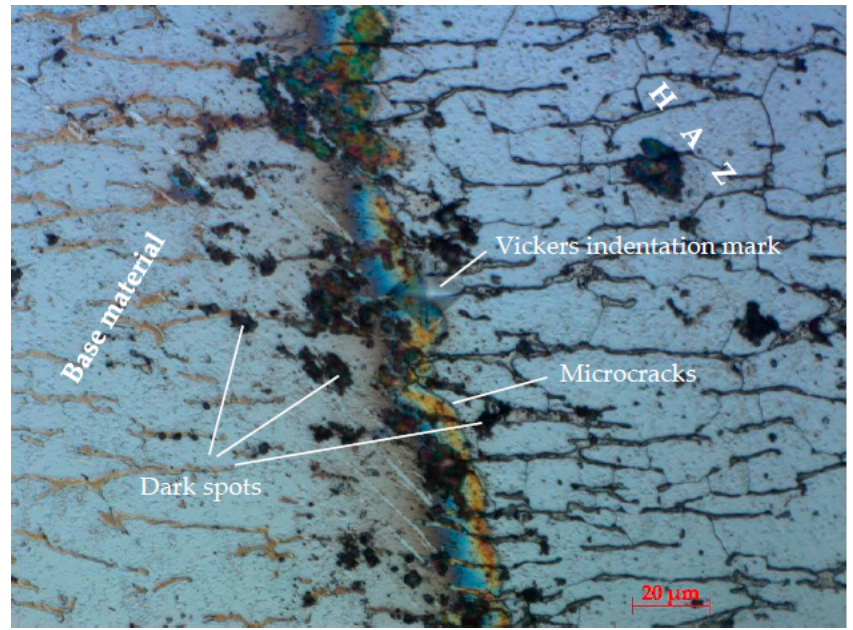
Figure 6. Microscope image of microstructure (cross-section) in the line between the base material and the heat-affected zone (air as assist gas).